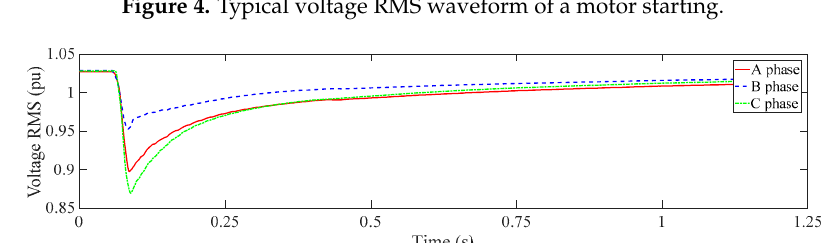
Figure 5. Typical voltage RMS waveform of a transformer energizing.